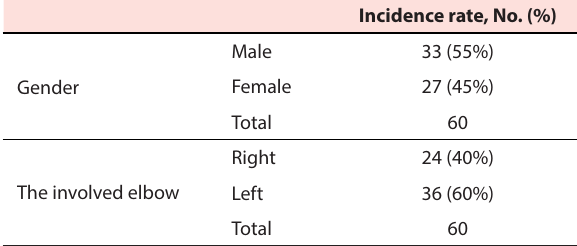
Table 1. A summary of descriptive statistics of the studied independent variables a